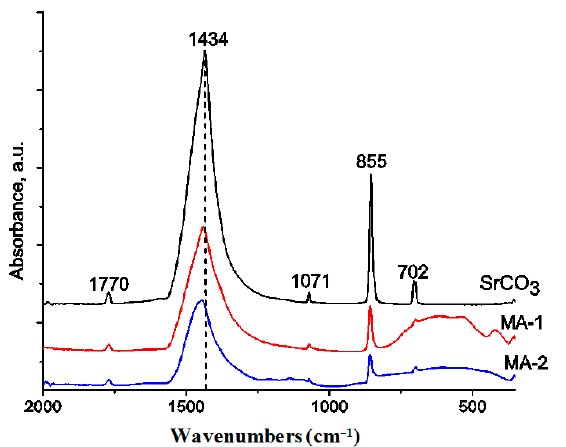
Figure 2. FT-IR spectra of the initial compounds and MA products after mechanical activation for